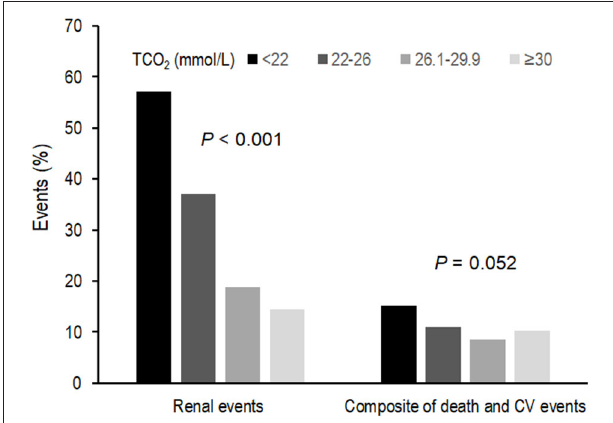
FIGURE 2 | Event rates for renal events and composite of secondary outcomes according to serum bicarbonate groups. Low, lower normal, higher normal, and high TCO 2 values were defined as < 22, 22–26, − 26.1 to 29.9, and ≥ 30 mmol/L, respectively. Patients in the low TCO 2 group (57.1%) were at a greater risk of developing renal events compared to the other TCO 2 groups ( P < 0.001). Patients in the low TCO 2 group (15.2%) tended to higher